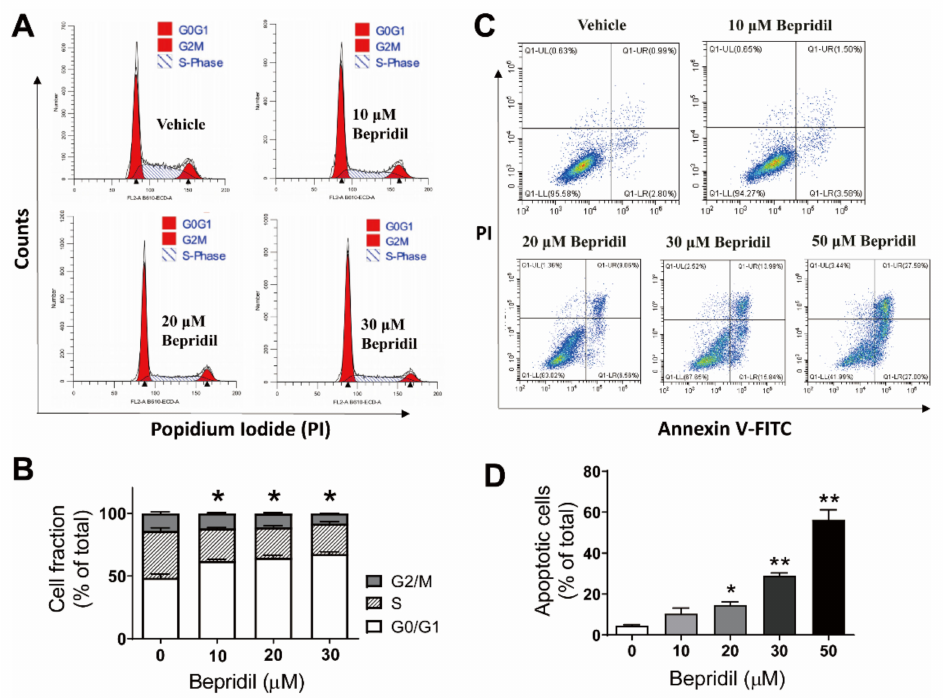
Figure 4. Bepridil-induced cell cycle arrest and apoptosis in melanoma cells. ( A , B ) Cell cycle profile of A2058 cells incubated with vehicle or bepridil (10, 20, and 30 µ M) for 18 h. The vehicle was cell culture medium containing DMSO (1/1000, v / v ). Bepridil increased the proportion of cells in G0/G1 phase. * p < 0.05, G0/G1 phase of bepridil treated groups vs. vehicle treatment, n = 5 experiments. ( C , D ) A2058 cells were treated with bepridil (10, 20, 30, 50 µ M) for 24 h and then analyzed with Annexin V-FITC/PI apoptosis assay. Bepridil increased the fraction of apoptotic cells (Annexin V+). * p < 0.05 and ** p < 0.01, compared with vehicle treatment; one-way ANOVA followed by a Tukey’s post-hoc test, n =